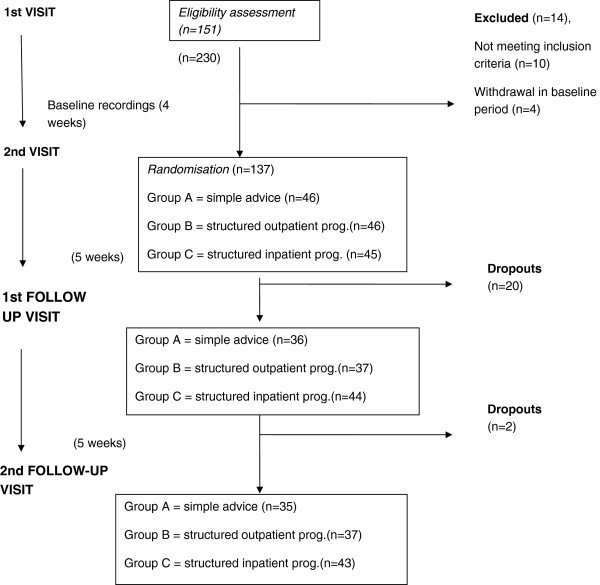
Outline of the trial.